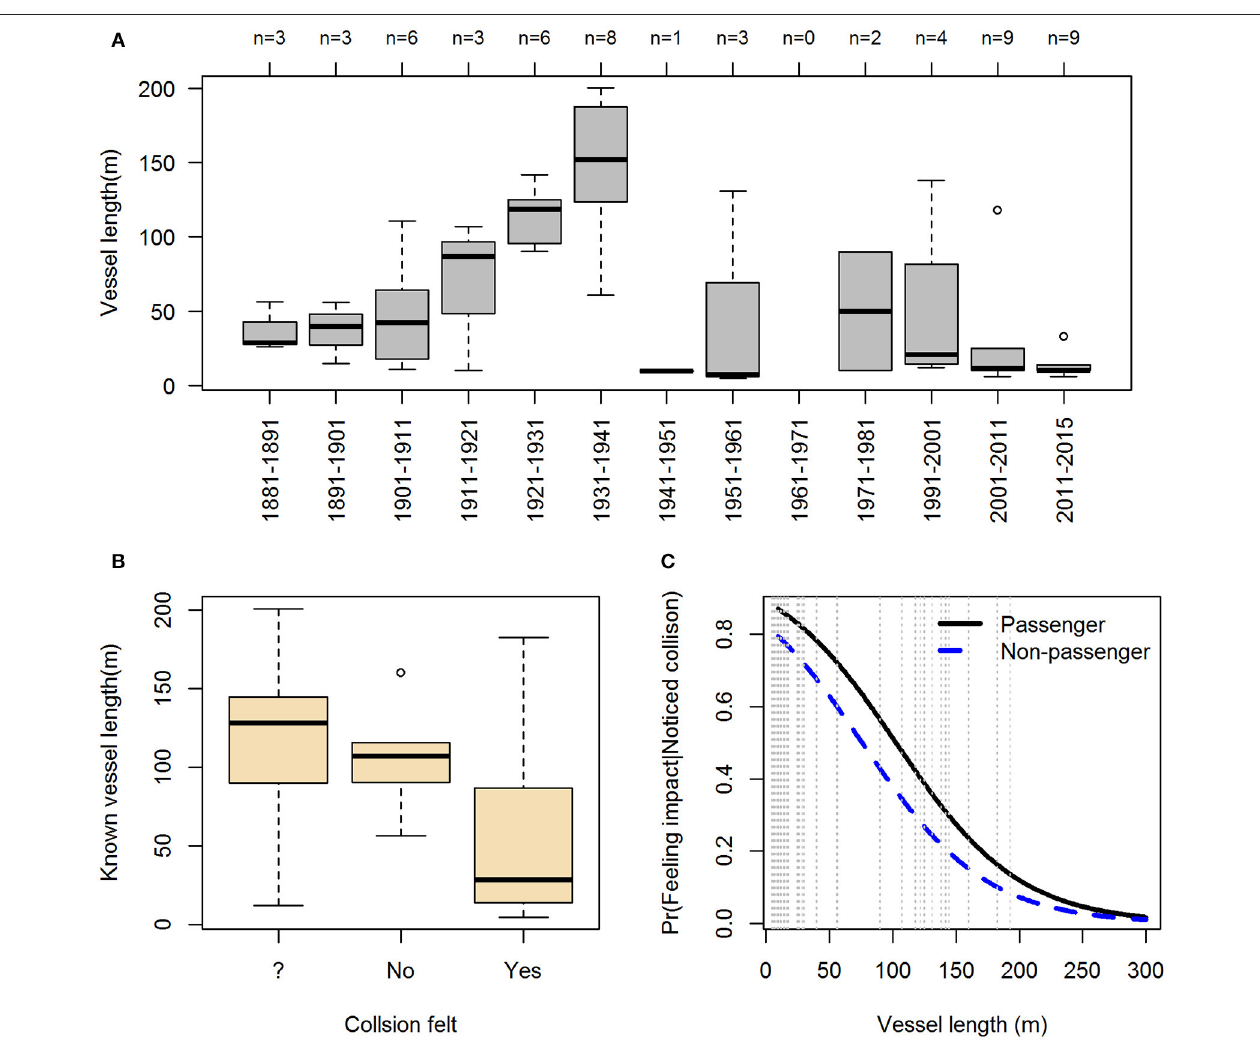
FIGURE 10 | From the Australian vessel strike data: (A) Distribution of known vessel lengths binned into 10-year periods. (B) Box plot comparison of the distribution of length for vessels where the collision was felt to those where it was not. (C) Modeled probability of vessel strike being felt vs. vessel length (vertical gray dotted lines = data, i.e., known length and information on if the collision was